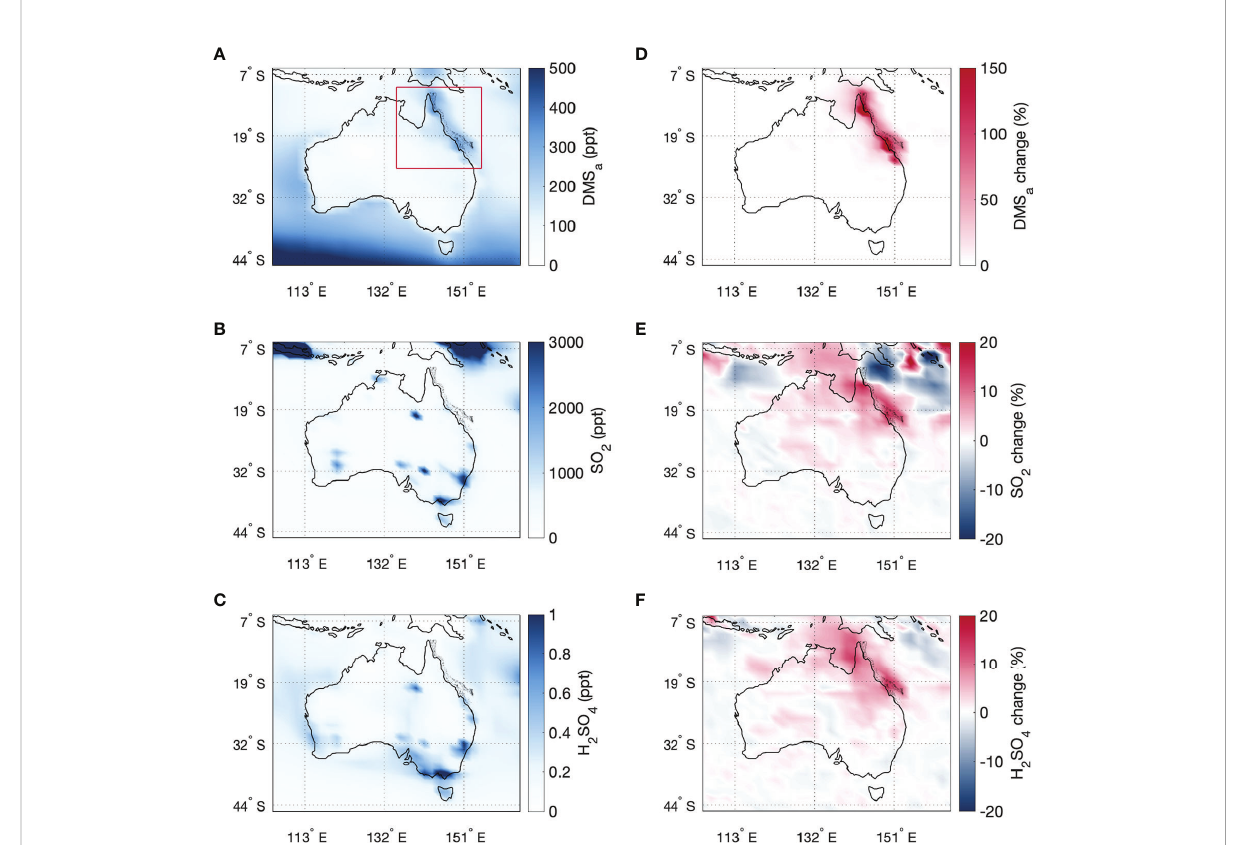
FIGURE 3 Annual mean (A) DMS a , (B) SO 2 and (C) H 2 SO 4 for the GBR DMS simulation, and (D – F) the percentage change in each variable between the GBR DMS and L11 simulations. The north-eastern Australian region (9.5-26°S; 135-155°E) for which the area-averaged changes are calculated for Table 2 is shown in red in panel (A)